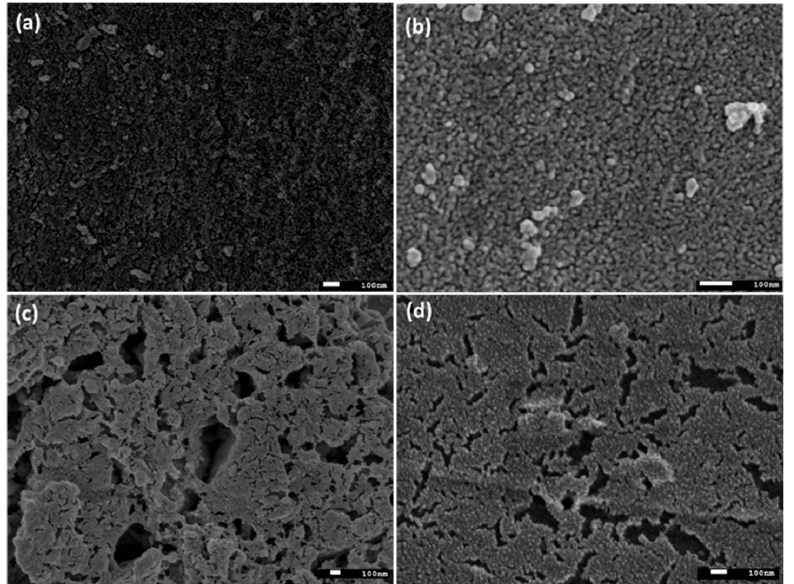
Figure 4. SEM images of silica ionogels: ( a ) IL 0 (×50 K), ( b ) IL 1.0 (×100 K), ( c ) IL 5.0 (×30 K), and ( d ) IL 10.0 (×50 K).